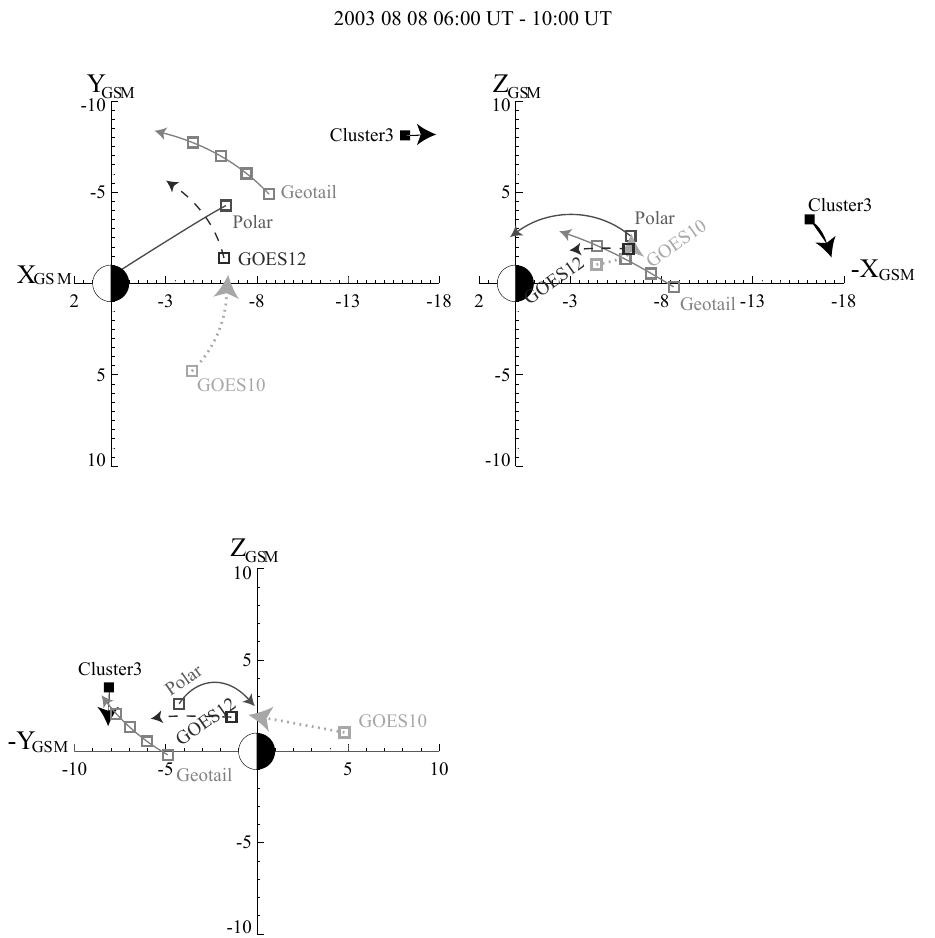
Fig. 2. The orbit configuration in three different planes (x-y, x-z and y-z) in GSM during 06:00–10:00 UT for all the satellites involved in this study, with the arrows indicating the